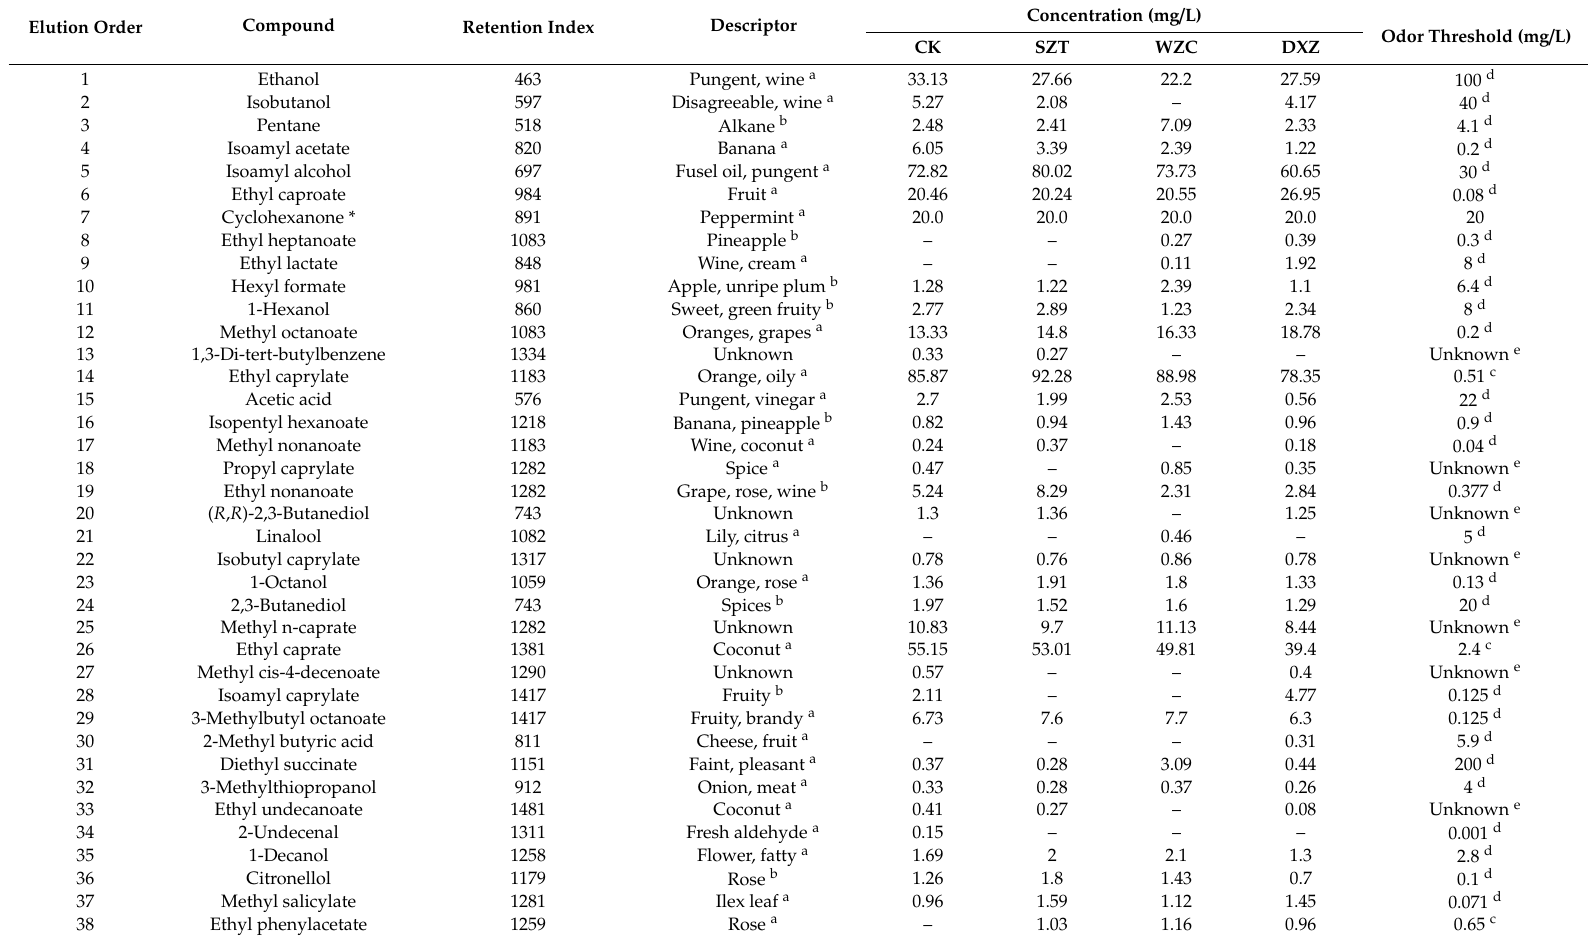
Table 1. Composition of the wine volatile substances determined by SPME-GC-MS